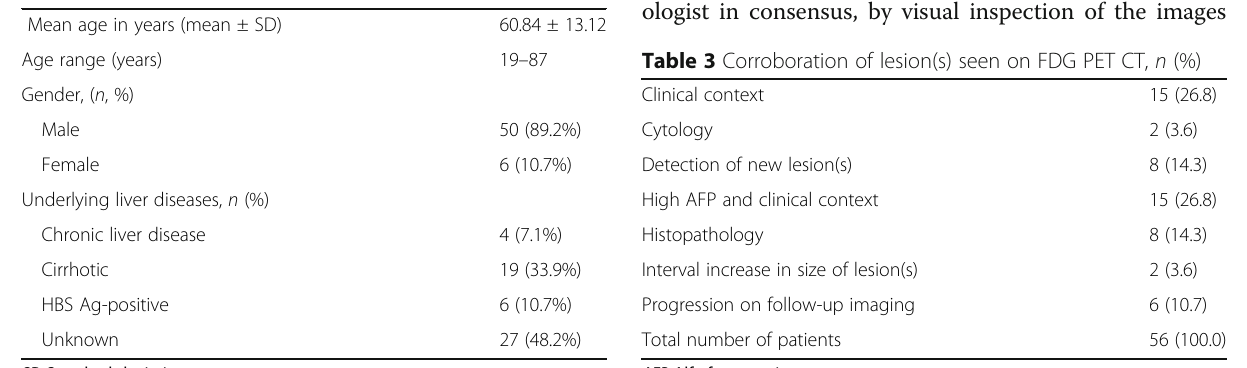
Table 1 Characteristics of patients, total ( n = 56) Variables